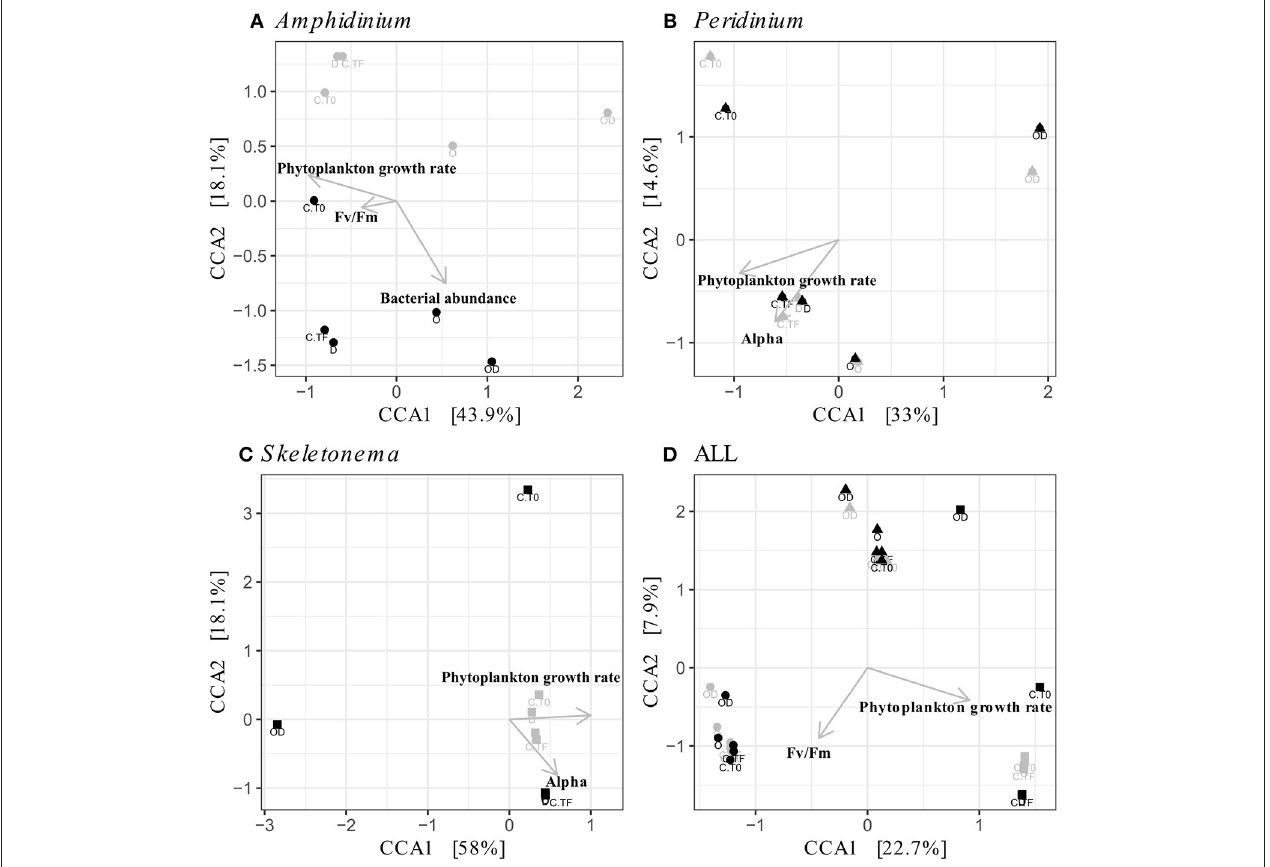
FIGURE 5 | Canonical Correspondence Analyses (CCA) of the phytoplankton-attached (PA, gray) and the free-living (FL, black) bacterial communities for each phytoplankton species: A. carterae ( A , circles), P. sociale ( B , triangles), Skeletonema sp. ( C , squares), and all species together (D) . Labels are the treatments: CT0 for control sampled at time 0, CTF for control sampled at final time point; D for dispersant, O for oil, and OD for dispersed oil all at final time